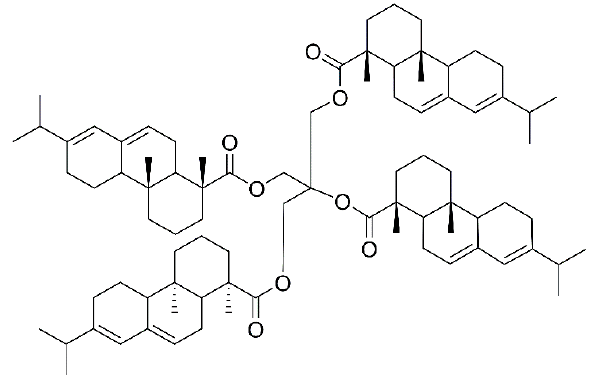
Figure 1. The molecular structure of RPE.